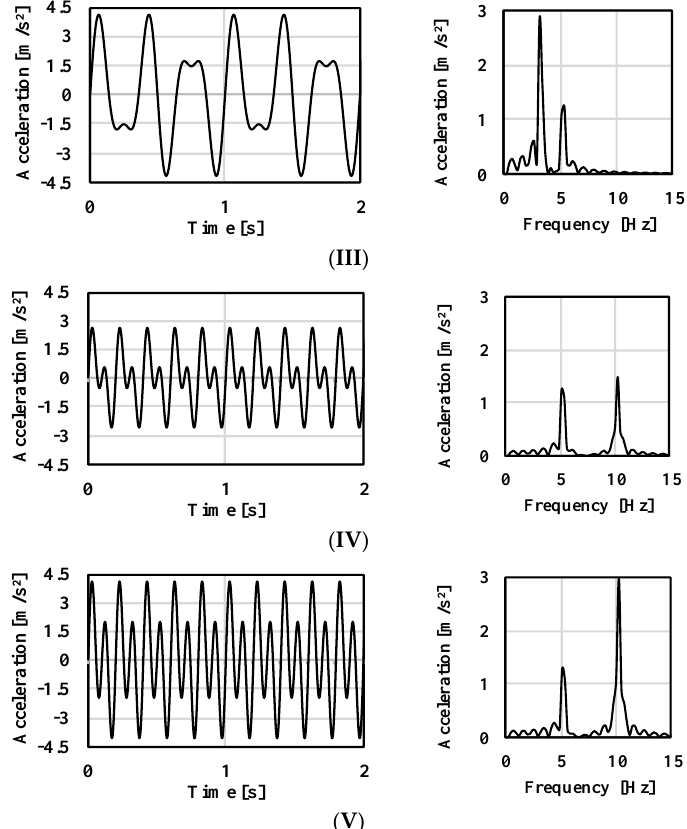
Figure 11. Time histories and spectra on each vibration condition of masking. ( I ) 5 Hz (amplitude: 1.5 m/s 2 ); ( II ) 5 Hz (1.5 m/s 2 ) + 3 Hz (1.5 m/s 2 ); ( III ) 5 Hz (1.5 m/s 2 ) + 3 Hz (3 m/s 2 ); ( IV ) 5 Hz (1.5 m/s 2 ) + 10 Hz (1.5 m/s 2 ); ( V ) 5 Hz (1.5 m/s 2 ) + 10 Hz (3 m/s 2 ).